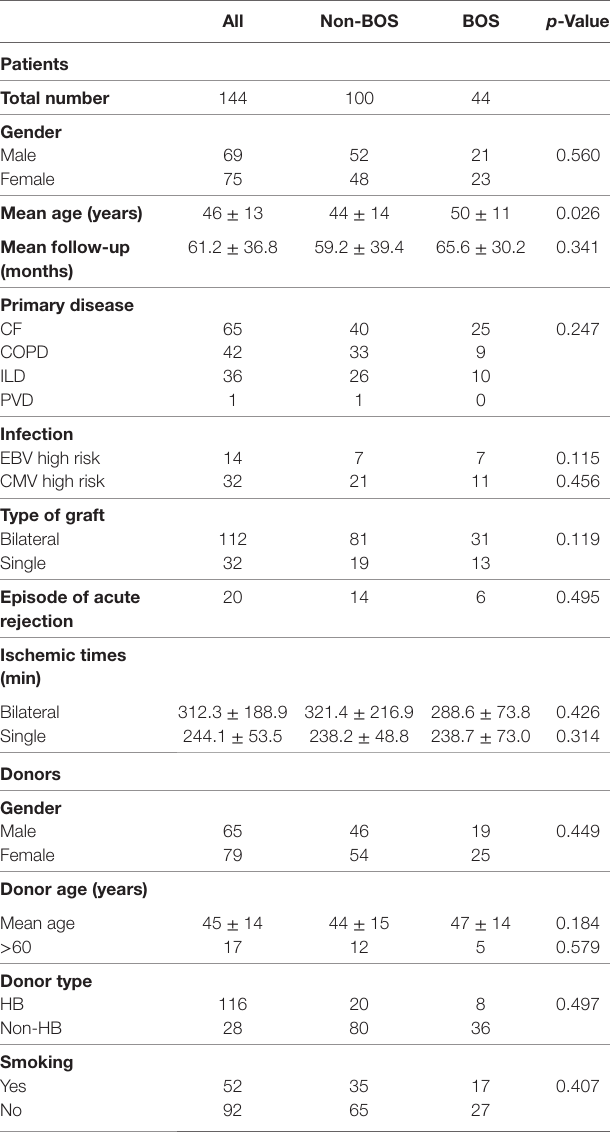
Table 1 | Clinical and demographic parameters of lung transplant patients and donors.